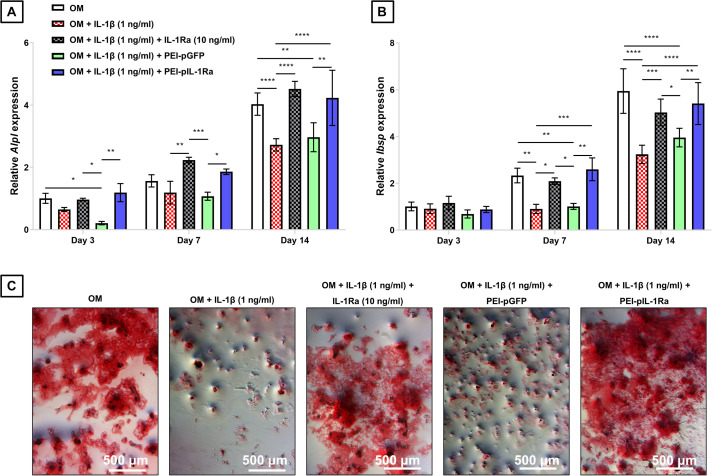
Effect of transfection with PEI-pIL-1Ra on rat BM-MSCs cultured in presence of IL-1β. Cells were transfected with either PEI-pGFP or PEI-pIL-1Ra and cultured with osteogenic media (OM) + IL-1β (1 ng/ml). For comparison, BM-MSCs were also cultured with OM, OM + IL-1β (1 ng/ml), and OM + IL-1β (1 ng/ml) + IL-1Ra (10 ng/ml). The effect of transfection with PEI-pIL-1Ra was assessed in terms of (A)
Alpl gene expression, (B)
Ibsp gene expression, and (C) mineral content deposition. *, **, ***, and **** denotes p < 0.05, 0.01, 0.001, and 0.0001 respectively. Data is normalized to gene expression of cells cultured in OM at day 3. Relative quantification was determined using the 2– ΔΔCT method. Data shown represents mean ± standard deviation, n = 3.